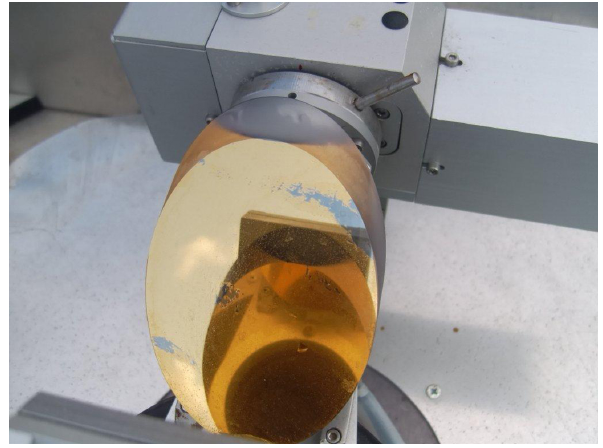
Figure 2. Surface damage on the original gold-coated mirror (Bruker) after 20days outside and one cleaning procedure. Photo: N. John.